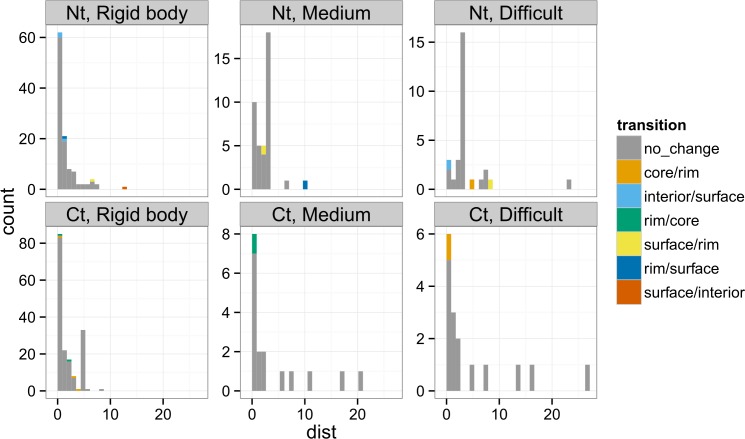
Distance between terminal residues in the Docking Benchmark version 5 after superimposition of bound and unbound forms.Cases are colored according to the interface regions in the unbound/bound conformations. Complexes are classified as ‘rigid body’, ‘medium’ or ‘difficult’ cases in the docking benchmark, based on the structural difference between the bound and the unbound forms.